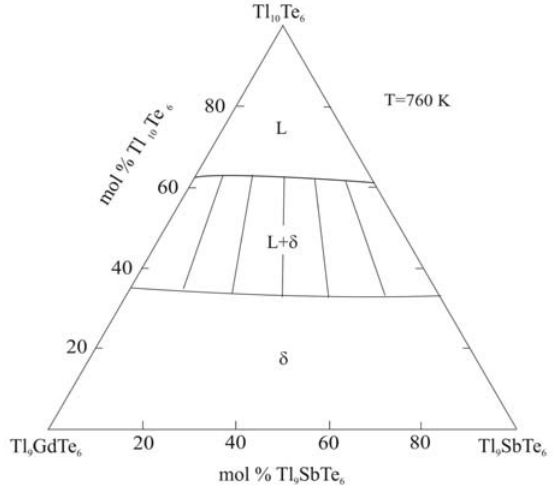
Fig.6. The isothermal section of the phase diagram at 760 K of the Te -Tl GdTe -Tl SbTe Tl 5 3 9 6 9 6